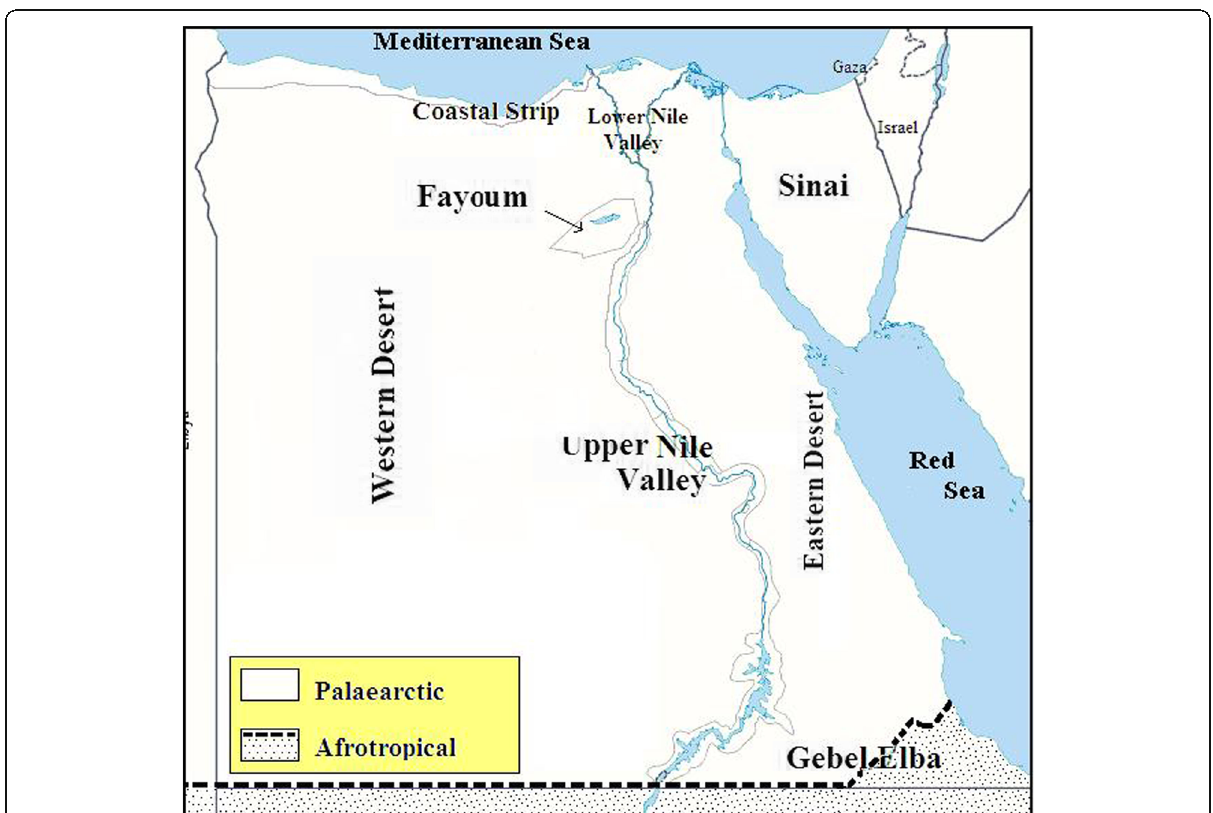
Fig. 1 Map of Egypt showing the ecological zones (after El-Hawagry and Gilbert